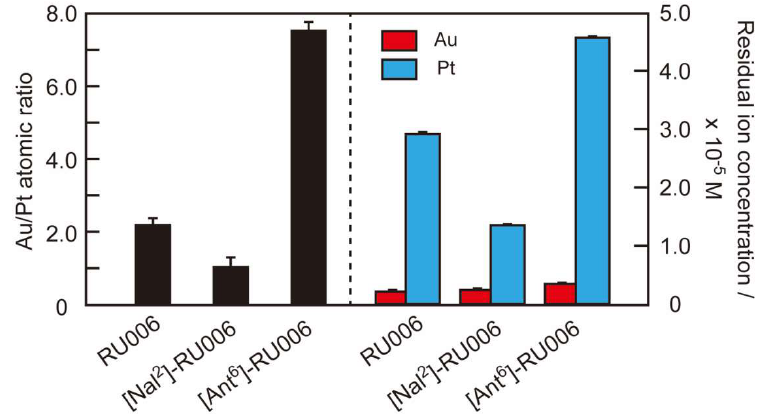
Figure 4. Gold/platinum (Au/Pt) atomic ratios of the metallic precipitates determined by energy- dispersive X-ray spectroscopy-scanning electron microscopy (EDS-SEM) (left axis) and residual metal ion concentrations in the supernatants determined by inductively coupled plasma-optical emission spectroscopy (ICP-OES) (right axis) with the peptides RU006, (NaI 2 )-RU006 and (Ant 6 )-RU006). Samples were separated by centrifuging the reaction mixtures of peptides and metal ions (HAuCl 4 + H 2 PtCl 6 ). (Peptide) = 2.0 × 10 −4 M and (HAuCl 4 ) = (H 2 PtCl 6 ) = 5.0 × 10 −5 M in water. Each reaction was conducted at 40 °C for 24 h in the dark (mean ± SD, n = 3).